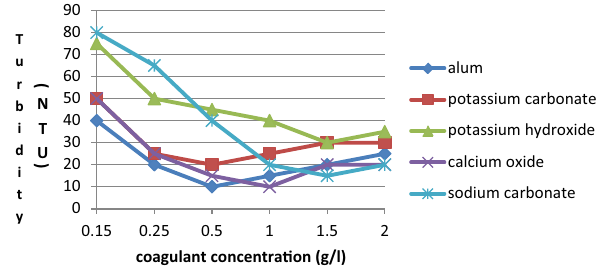
Fig. 3 Turbidity at varying doses of coagulants (pH 6)